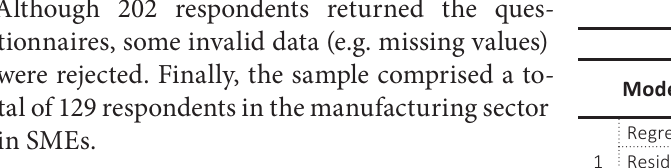
Table 3. Appropriateness of the